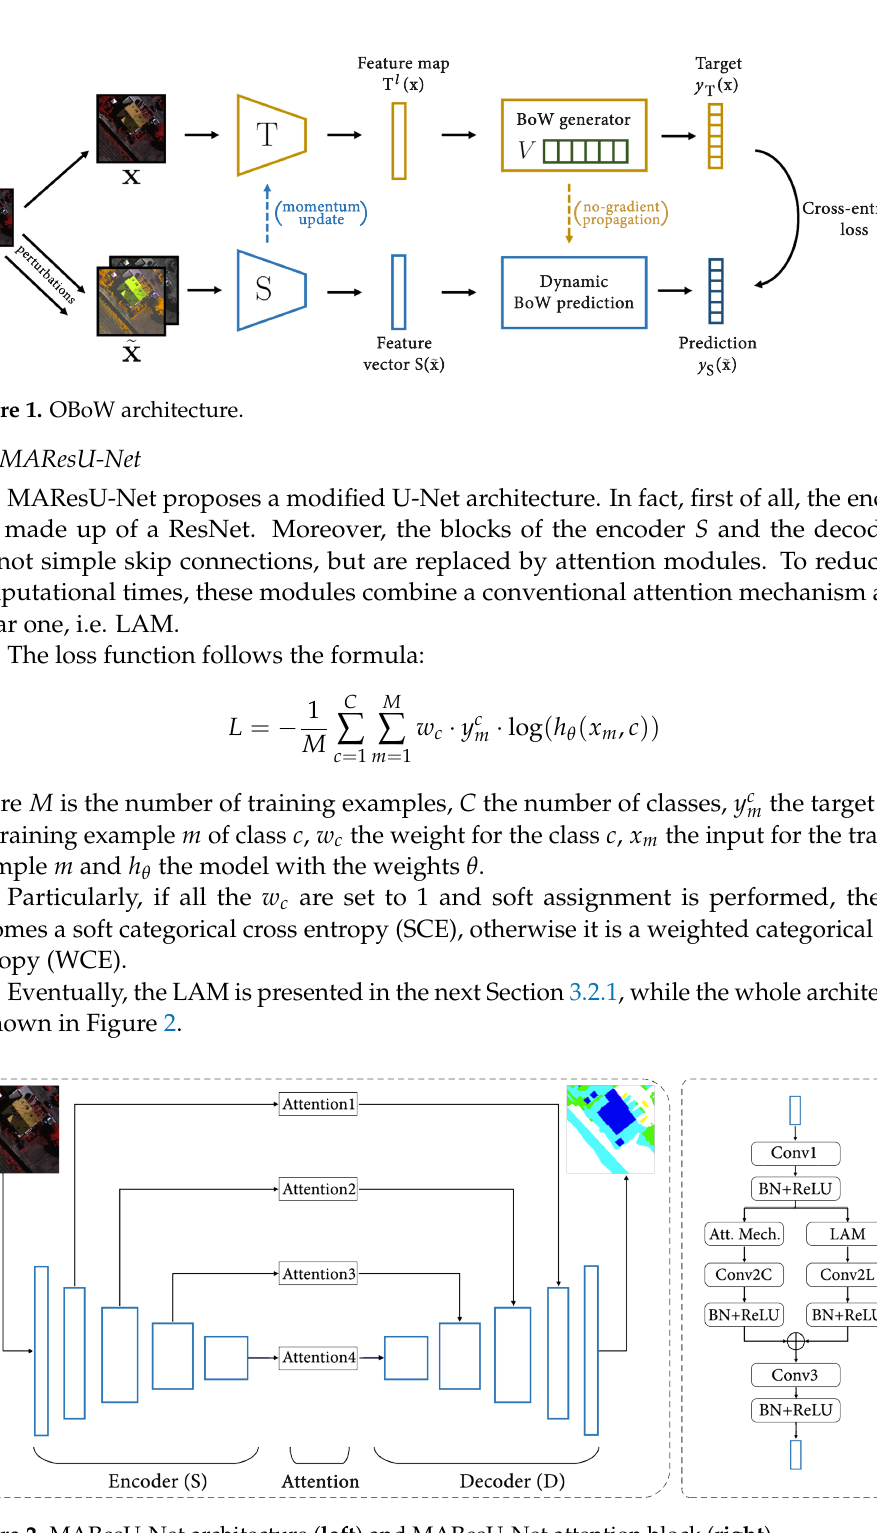
Figure 2. MAResU-Net architecture ( left ) and MAResU-Net attention block ( right